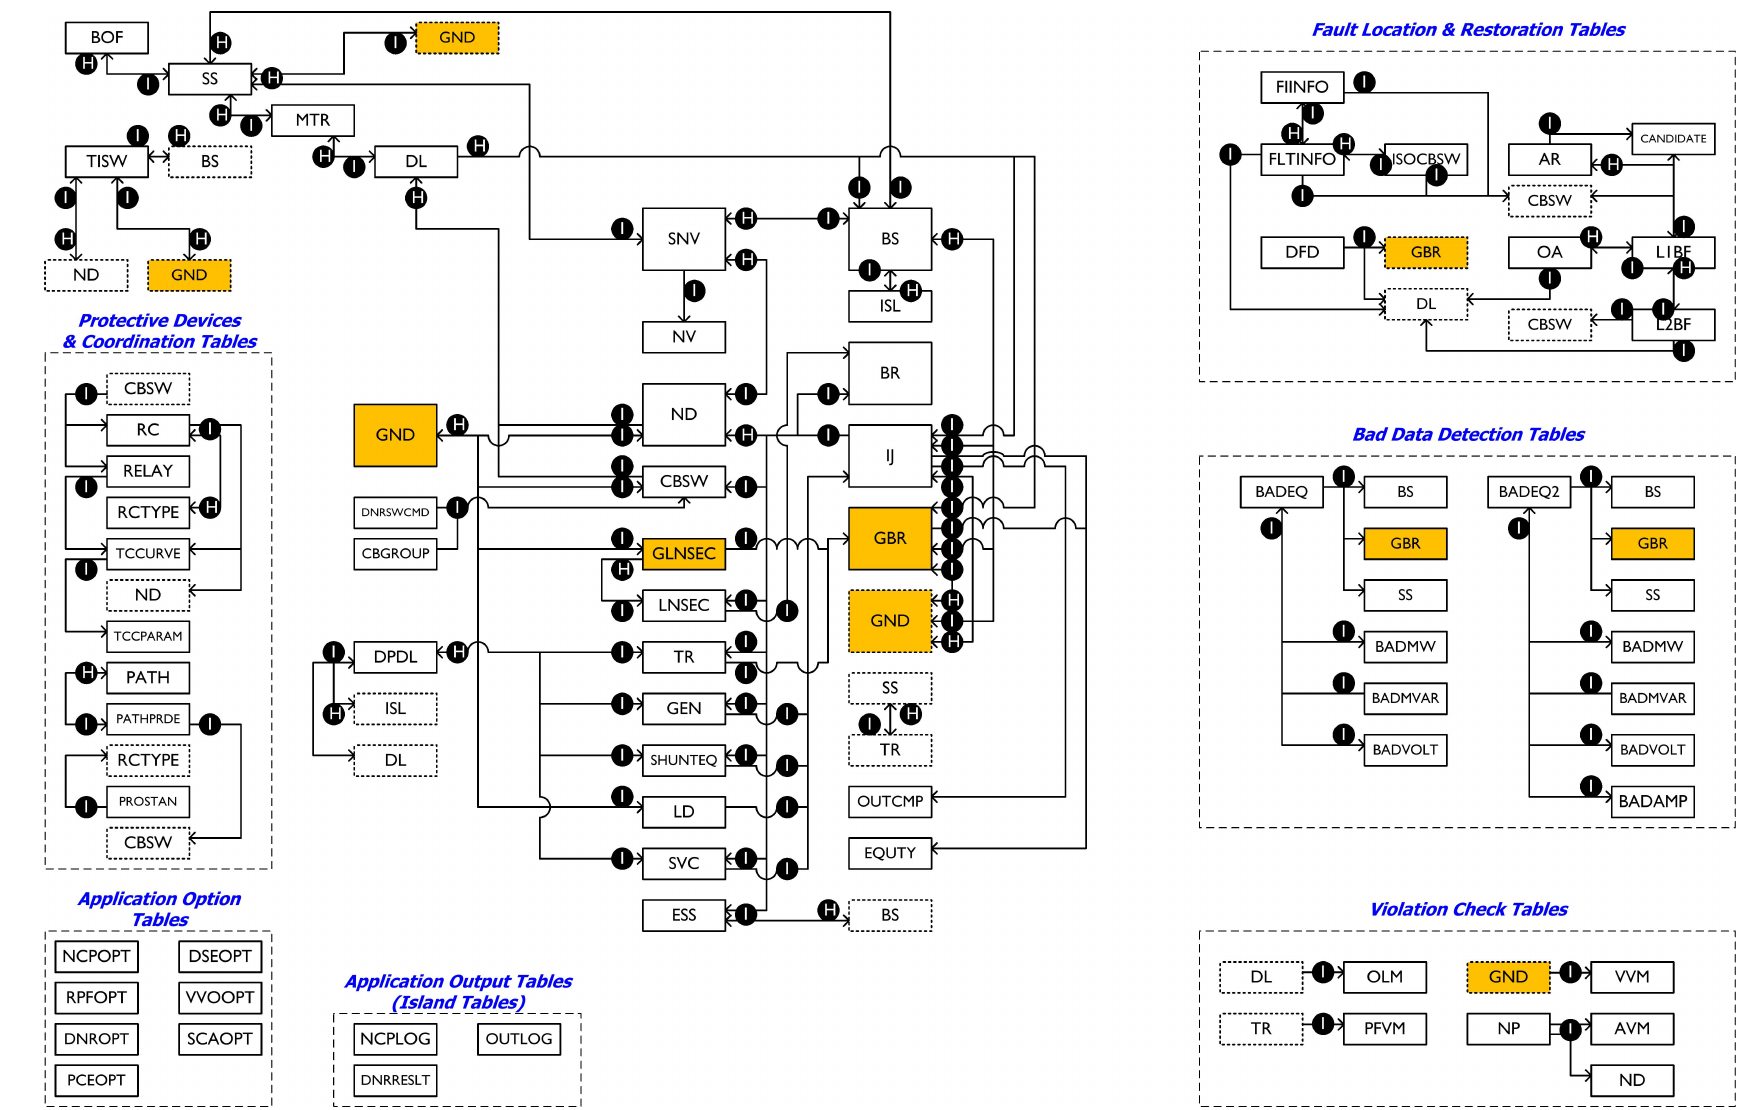
Figure 9. Structure of the common application